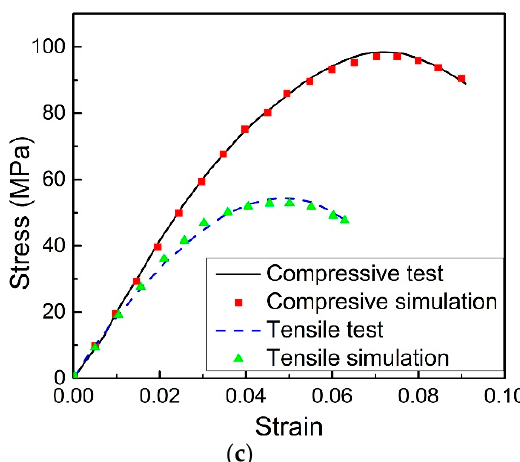
Figure 11. ( a ) Tensile and ( b ) compressive plastic-damage parameters of the 3D-printed VeroWhite Plus materials; ( c ) Comparison of stress-strain curves of the tensile dog-bone shaped specimen and compressive cubic specimen: experiments and numerical simulations.